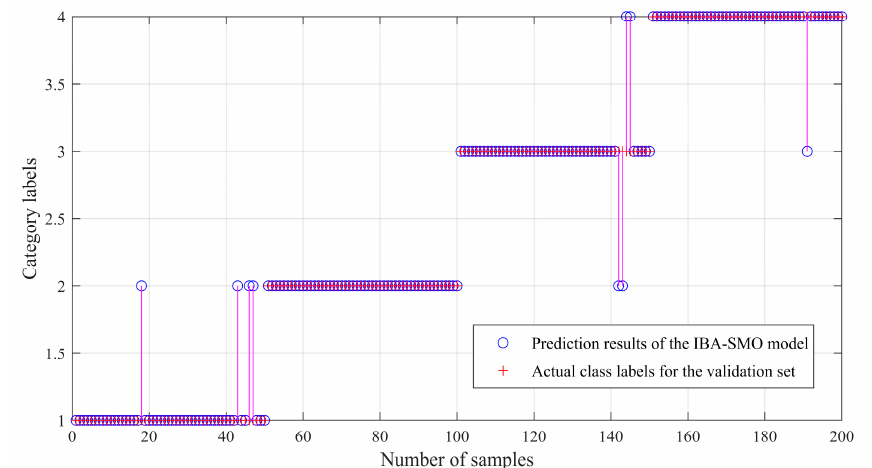
Figure 11. IBA-SMO Model verification.